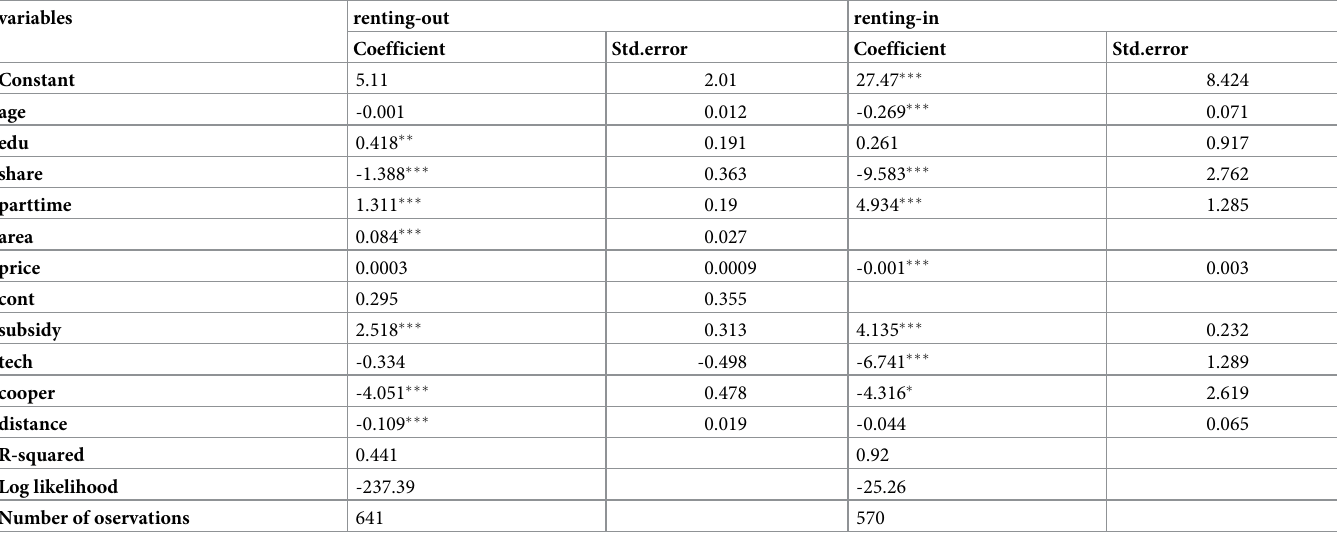
Table 4. Results of Logistic model: Determinants of farmers’ participation in land rental